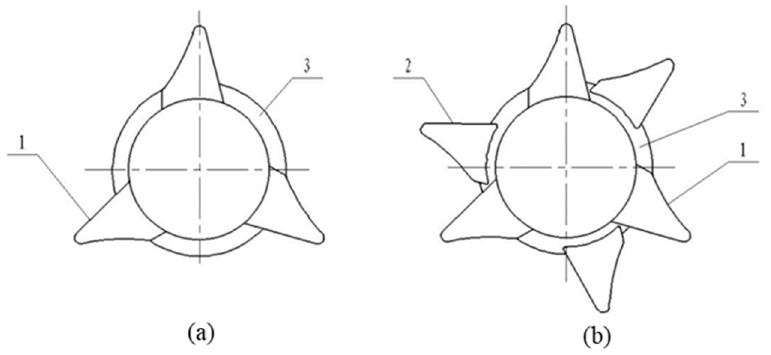
Figure 12. Gear arrangement. ( a ) Linear arrangement; ( b ) Nonlinear arrangement; 1, First layer gear; 2, Second layer gear; 3, Drum. 2, Second layer gear; 3, Drum.